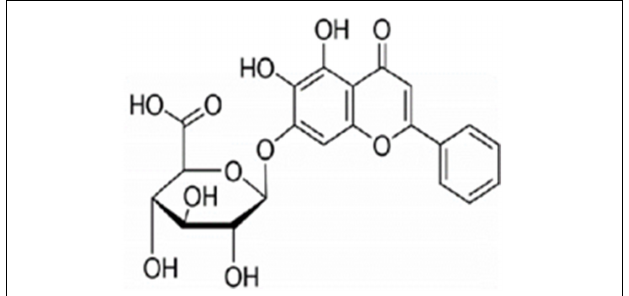
FIGURE 1 | Chemical structure of baicalin (Moore et al.,